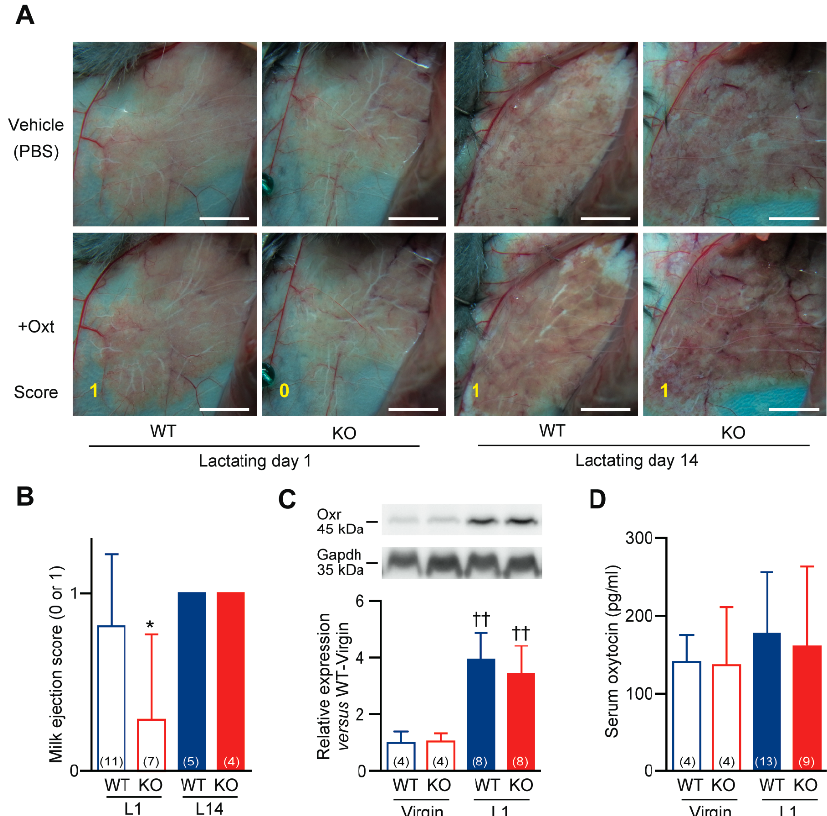
Figure 6. Impaired oxytocin-induced milk ejection in the epithelial ducts of Cth − / − mammary gland. ( A ) Abdominal regions of lactating day 1 (L1)/L14 wild-type (WT) and Cth − / − (KO) mice were exposed and oxytocin (0.04 unit) was applied. The increased amount of milk in the larger duct was detected (score 1) or not detected (score 0). ( B ) Milk ejection scores in L1/L14 WT and KO mice. Milk ejection scores were the smallest in L1 KO mice (* p < 0.05 versus L1 WT and L1/L14 KO). ( C ) Western blot analyses of oxytocin receptor (Oxr) in virgin/L1 WT and KO mice. Oxr expression was upregulated in L1 WT and KO mice ( †† p < 0.01 versus their respective virgin) to similar levels. ( D ) Serum oxytocin levels in virgin/L1 WT and KO mice. Data are represented as mean ± SD ( n in parentheses).